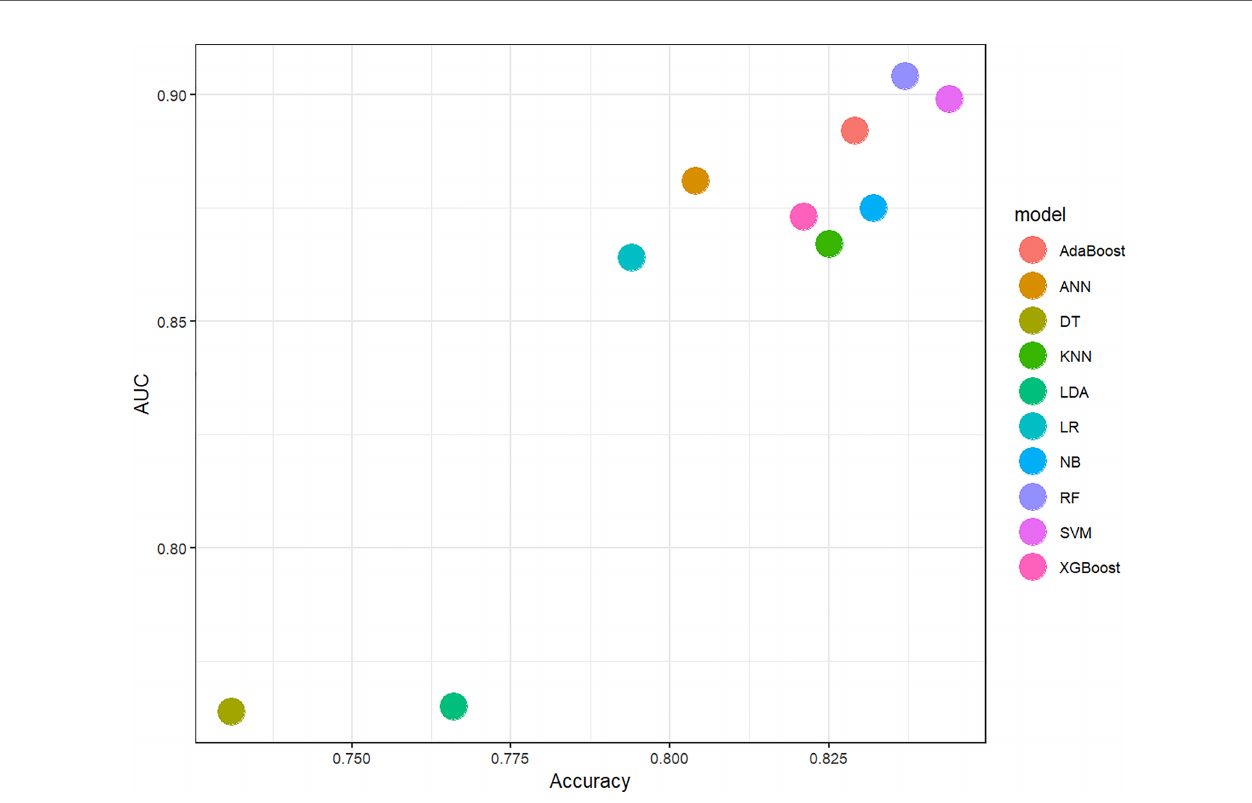
FIGURE 3 | Scatter diagram of machine learning classi fi ers prediction performance. The horizontal axis represents ACC, the vertical axis represents AUC. AUC, The area under the receiver operating characteristic curve; ACC, Accuracy; LR, Logistic Regression; LDA, Linear Discriminant Analysis; NB, Naive Bayes; KNN, K- Nearest Neighbor; SVM, Support Vector Machine; DT, Decision Tree; RF, Random Forest; XGBoost, eXtreme Gradient Boosting; ANN, Arti fi cial Neural Network.